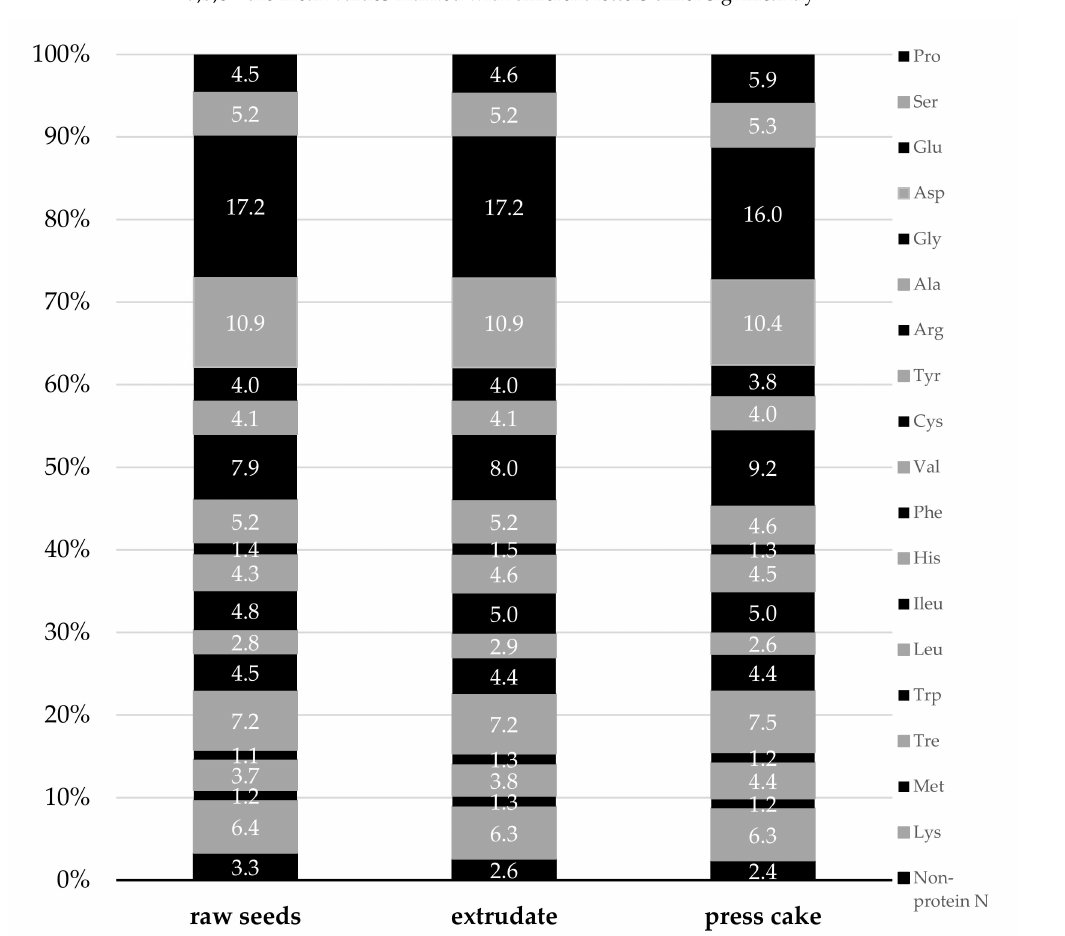
Figure 3. The content of amino acids (g) in 100 g of protein in raw soybean seeds and processed feed